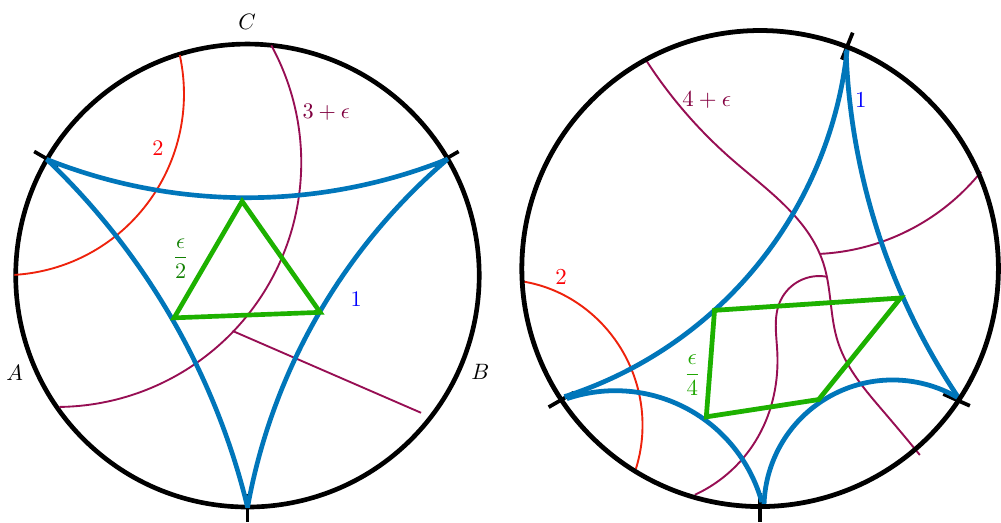
Figure 5 . L: an example for AdS 3 with three boundary regions. We look for a maximal hyperthread configuration with the added condition that we want as many 3-threads as possible. The minimal surface configuration to this perturbed problem is given by m with the 3-threads saturating the 2 green triangle, t , which is finite. Complimentary slackness guarantees that any 2-threads which 3 cross any piece of t will not contribute. This essentially combs the 2-threads away from the center 3 so that the 3-threads will reside there. Similarly, any 3-threads which would split inside t will 3 not contribute. R: another example for four unequal boundary regions. The maximum number of 4-threads is given by 1 area( t ) 4 4